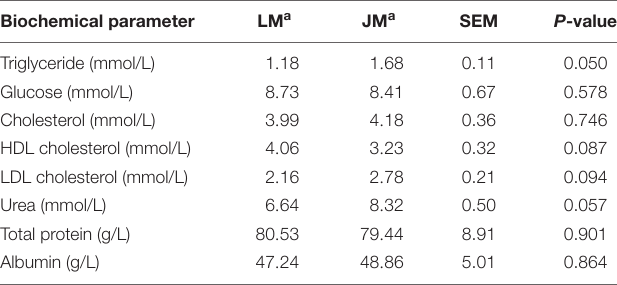
TABLE 2 | Biochemical parameters in the sera of mice receiving fecal microbiota of Landrace and Jinhua pigs. Biochemical parameter LM a JM a SEM P -value